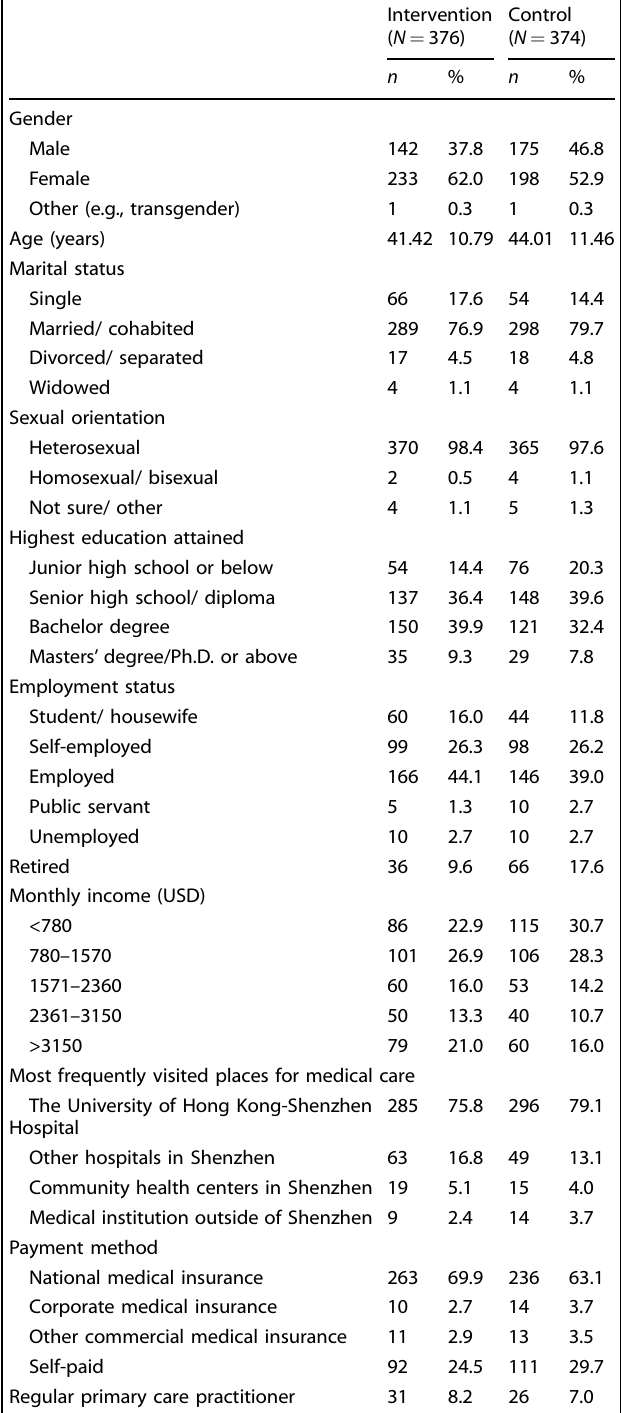
Table 1. Descriptive summary showing the socio-demographic characteristics of 750 primary care users enrolled in an online randomized controlled trial to evaluate a crowdsourced intervention on improving hepatitis testing in China, 2019 –